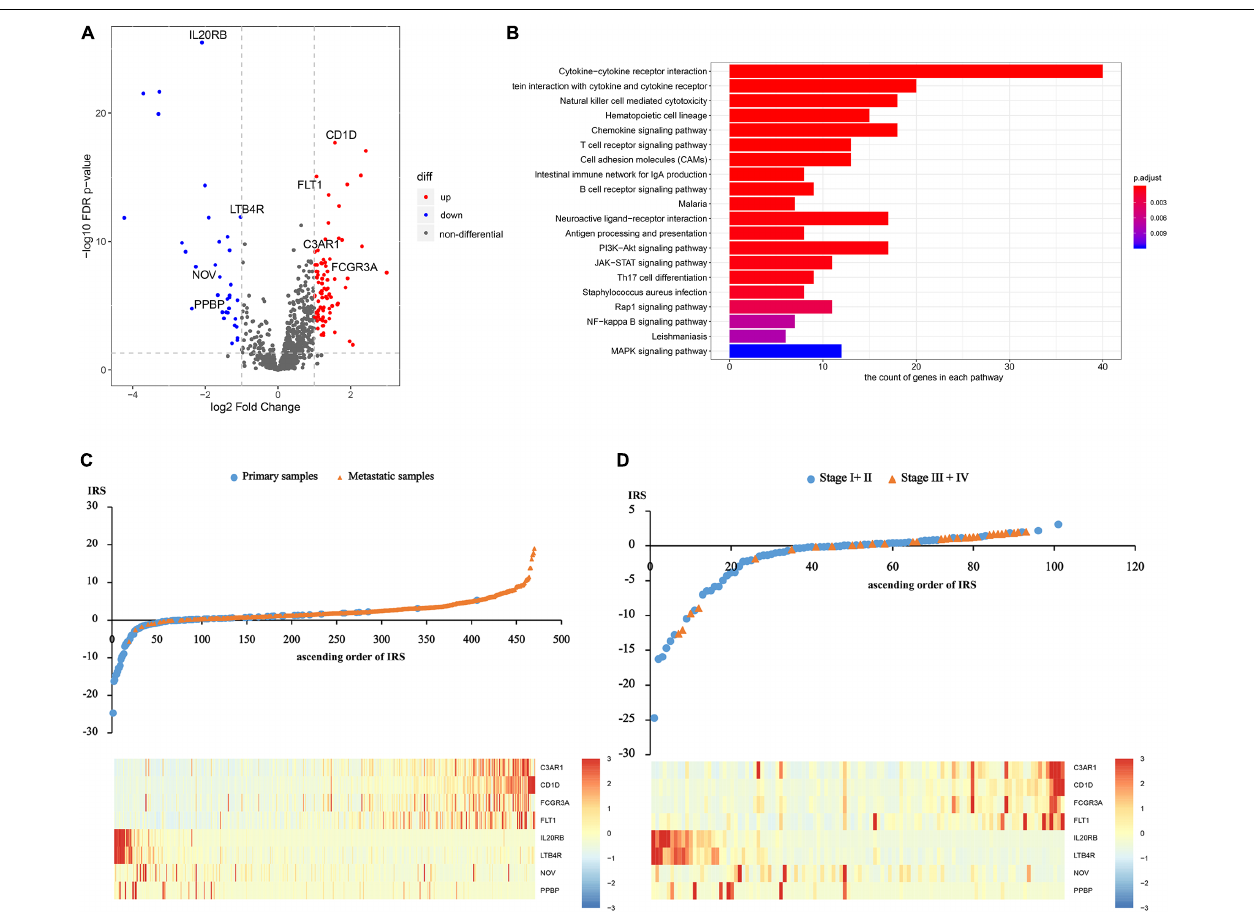
FIGURE 1 | Construction of the immune risk score. (A) The volcano plot of significantly differentially expressed IRGs. (B) The significantly differentially expressed IRGs involved KEGG pathways. (C) and (D) Distribution of the IRS and gene expression among sequencing samples and the initial patients.